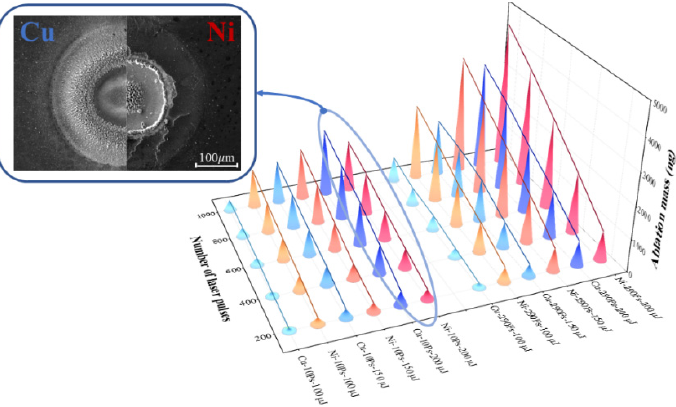
Figure 9. Variation trends in ablation mass of copper and nickel.